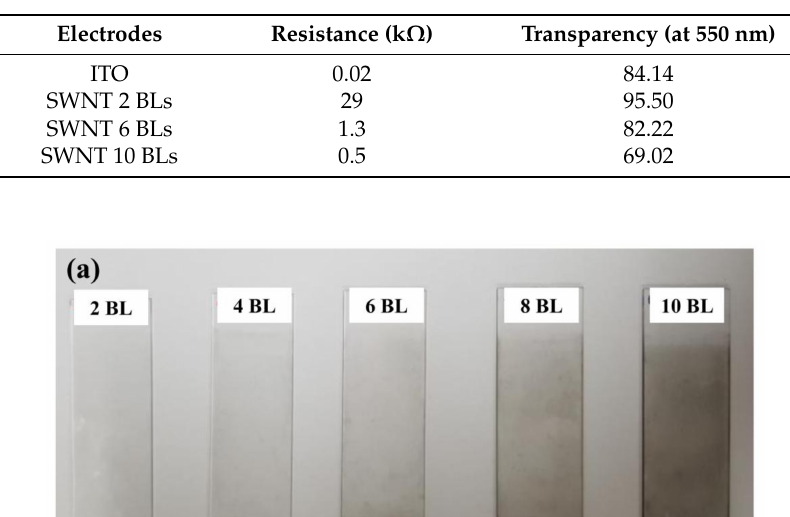
Table 1. Electric and optical properties of ITO and SWNT LBL electrodes.